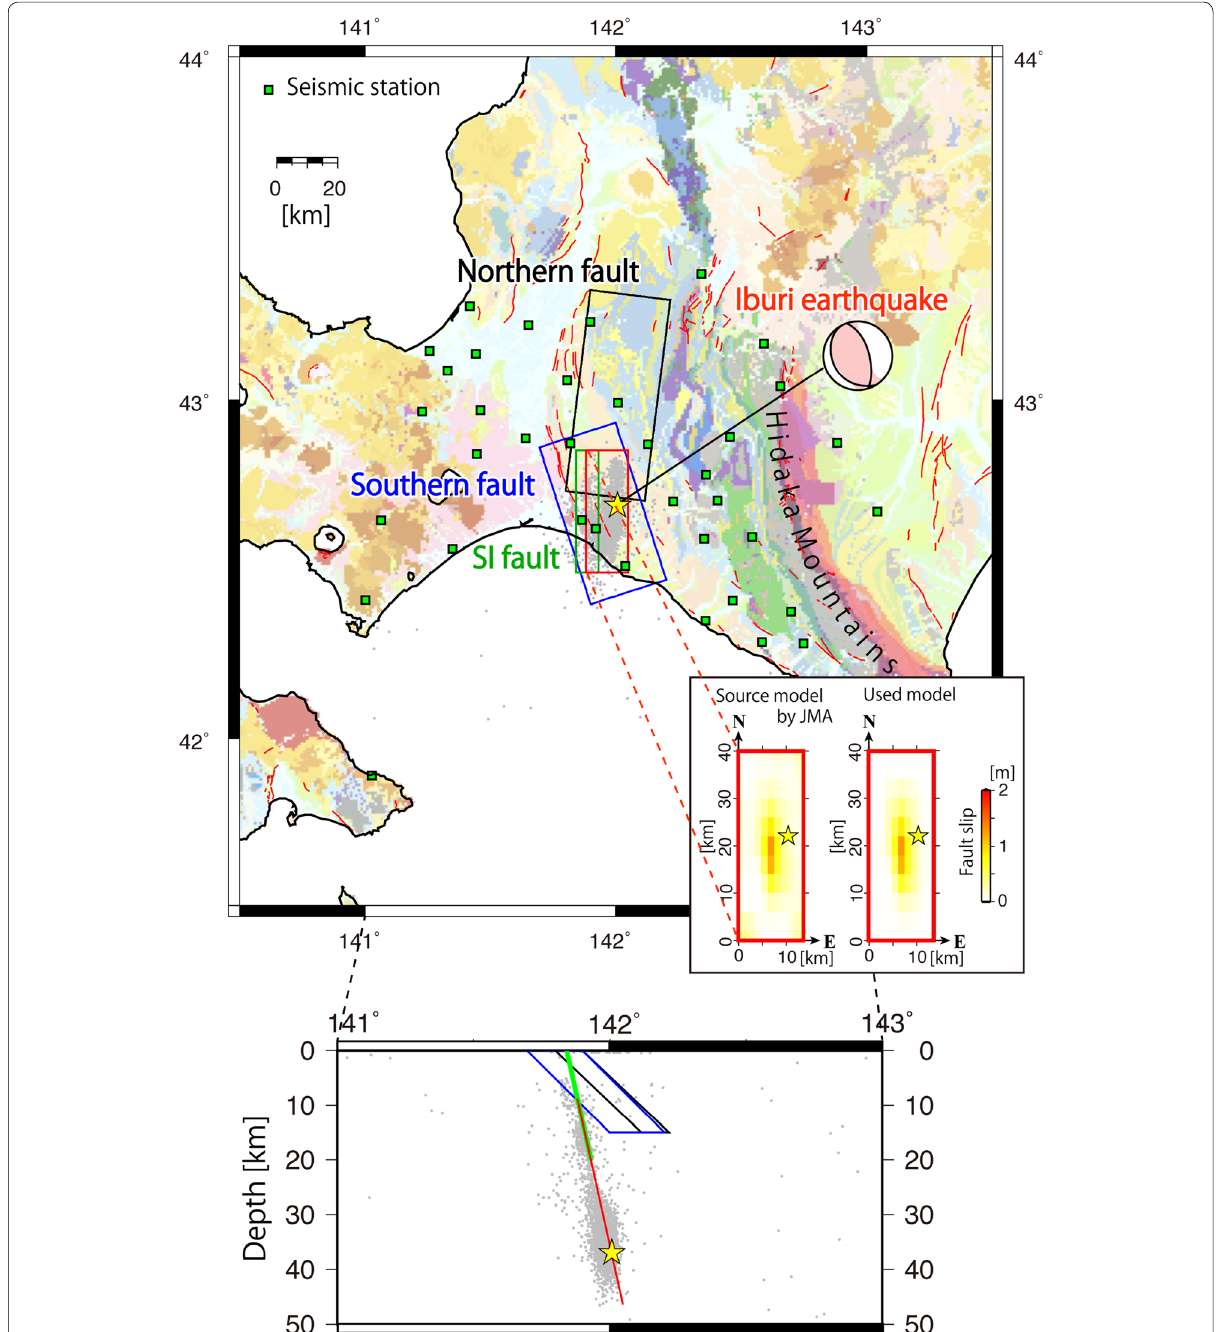
Fig. 1 Map of the Iburi earthquake and the three target faults in the present study, shown with the geological map (see details in GeomapNavi; https ://gbank .gsj.jp/geona vi/geona vi.php). The black, blue, and green rectangles indicate the surface projection for the geometry of the three target faults: the northern fault, the southern fault in the Ishikari fault zone, and the SI fault, respectively. The star and gray circles indicate the hypocenter of the mainshock and the 40-day aftershocks based on the earthquake catalog of Japan Meteorological Agency. The “beach ball” represents the centroid moment tensor solution for the mainshock by Japan Meteorological Agency (https ://www.data.jma.go.jp/svd/eqev/data/ mech/cmt/fig/cmt20 18090 60307 59.html. Accessed: January 29, 2019). The red rectangle shows the surface projection of the Iburi earthquake fault estimated by Japan Meteorological Agency (2018). The original fault slip distribution and the modified distribution used in the present study are shown on the left and right of the right lower panel. Red lines indicate active faults after Research Group for Active Faults of Japan (1991). The small green squares represent seismic stations used for analysis. The location of Hidaka Mountains is also indicated. The bottom panel shows the target faults, the mainshock, and the aftershocks projected onto the E–W vertical